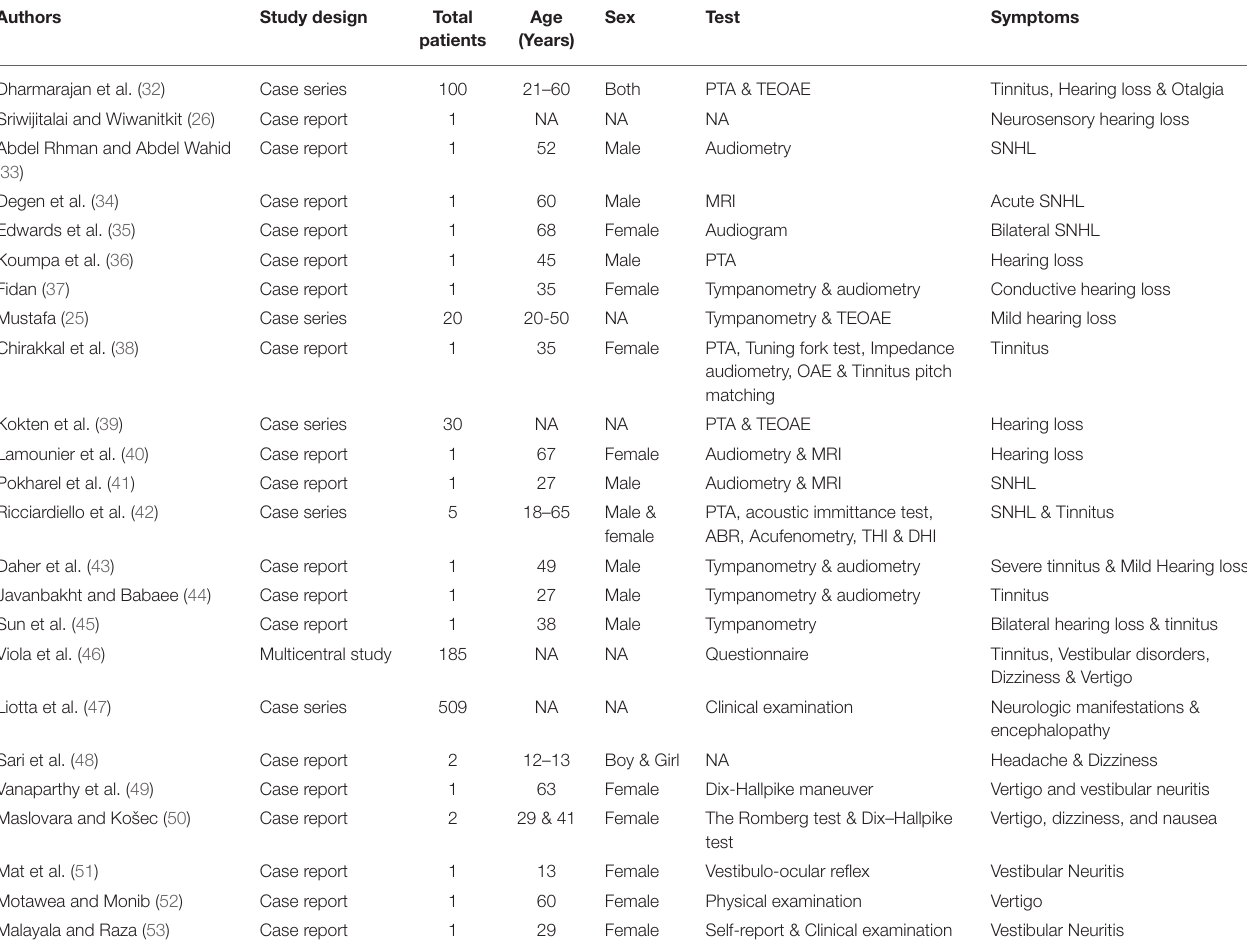
TABLE 2 | The detailed otological information in each